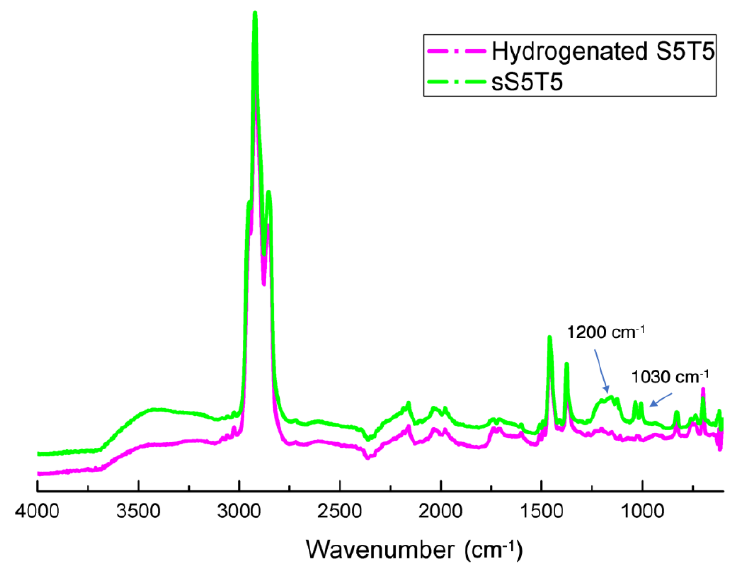
Figure 3. ATR-FTIR spectra of the hydrogenated S5T5 and sulfonated hydrogenated S5T5 (sS5T5). The contact angle of hydrogenated and sulfonated hydrogenated SIS membranes